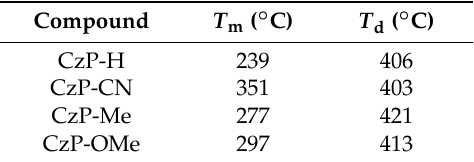
Figure 1. Thermogravimetric analysis (TGA) curves for CzP-H, CzP-CN, CzP-Me, and CzP-OMe. Table 1. Thermal properties of CzP-H, CzP-CN, CzP-Me and